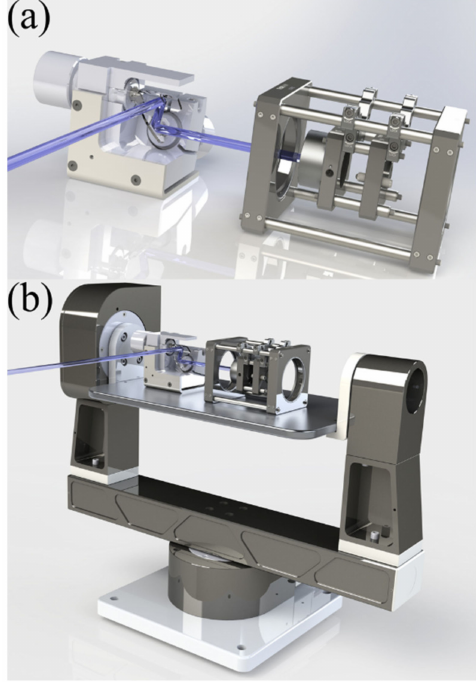
Figure 6. ( a ) Mounting system with galvo mirror and lens; ( b ) mounting system with added 2-axis gimbal. The transparent blue line represents the laser path.